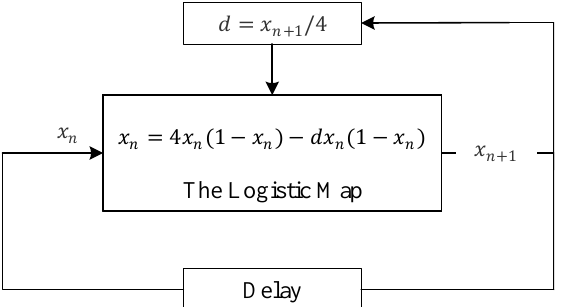
Figure 5. The block diagram of the enhanced logistic map.